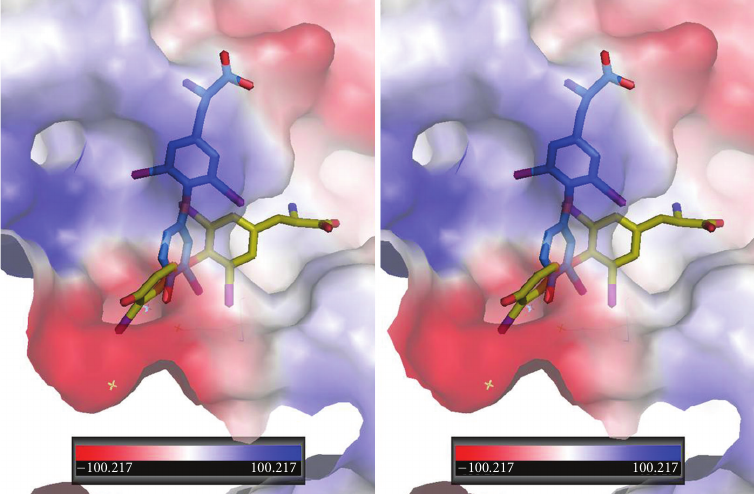
Figure 5: Stereoview of QM/MM model for T 3 bound in α v β 3 integrin at the RGD binding site. T 3 bound in two orientations: one orientation (yellow, Ca1) has the phenolic ring binding in a di ff erent pocket than that of T 4 while the other orientation of T 3 (blue, Ca2) binds in a mode that is perpendicular to the